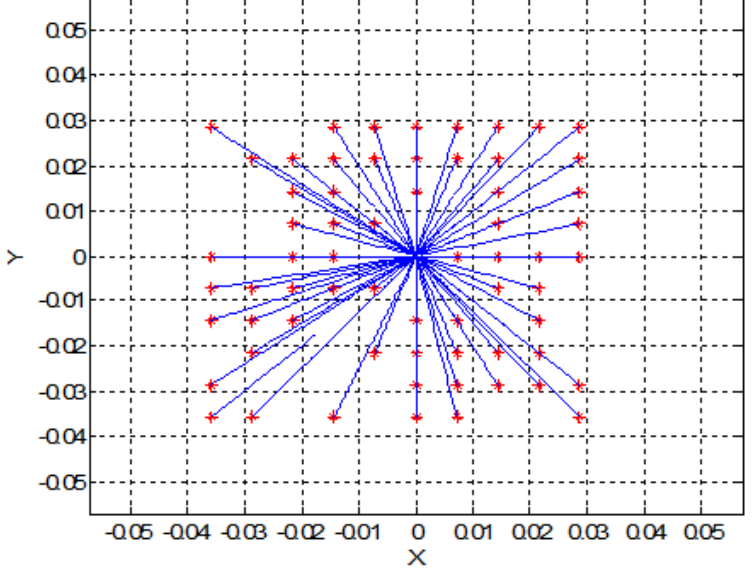
Figure 5. Trajectory of seventy nanoparticles under one magnetic field source (units are mm).